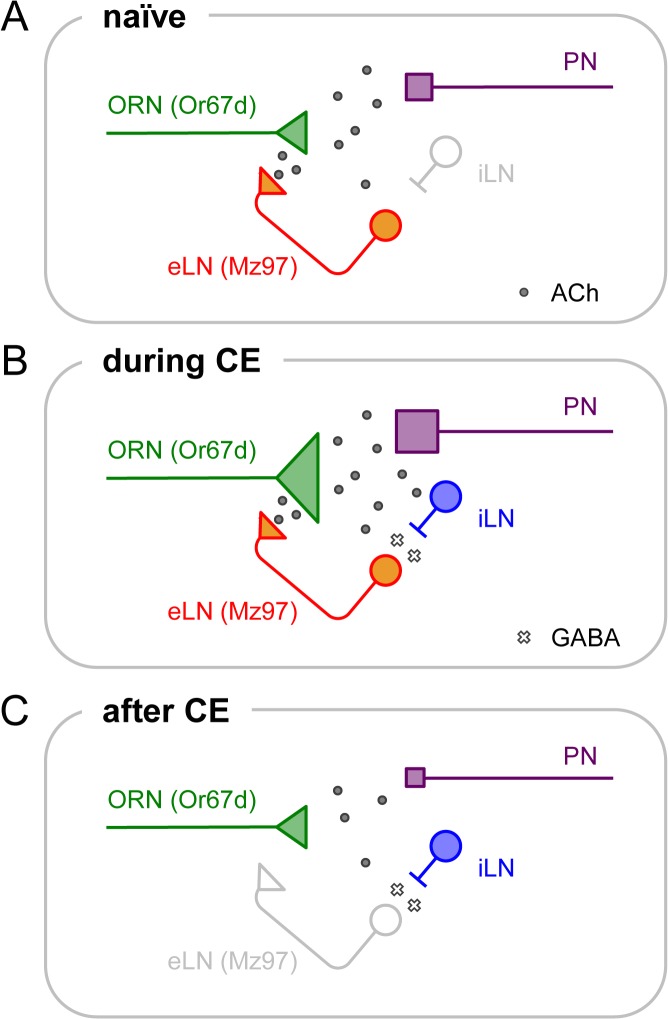
Recurrent inhibitory circuit plastically reduces signal intensity.(A) The Mz97 LNs provide presynaptic excitatory inputs into the Or67d ORNs in a naïve fly. (B) Continuous odor exposure facilitates the iLNs that provide inhibitory inputs to the Mz97 LNs. (C) Suppression of the Mz97 activity weakens the odor signal from the ORNs and downstream behavioral responses.